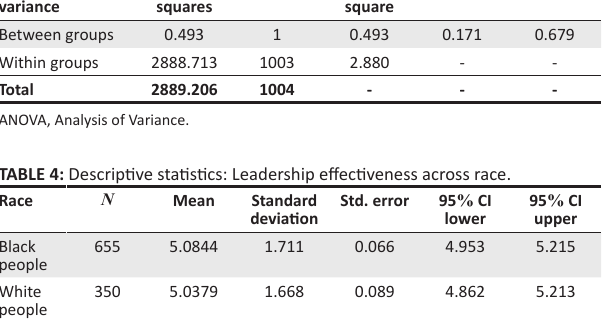
TABLE 2: Descriptive statistics: leadership styles across race. Variable Race